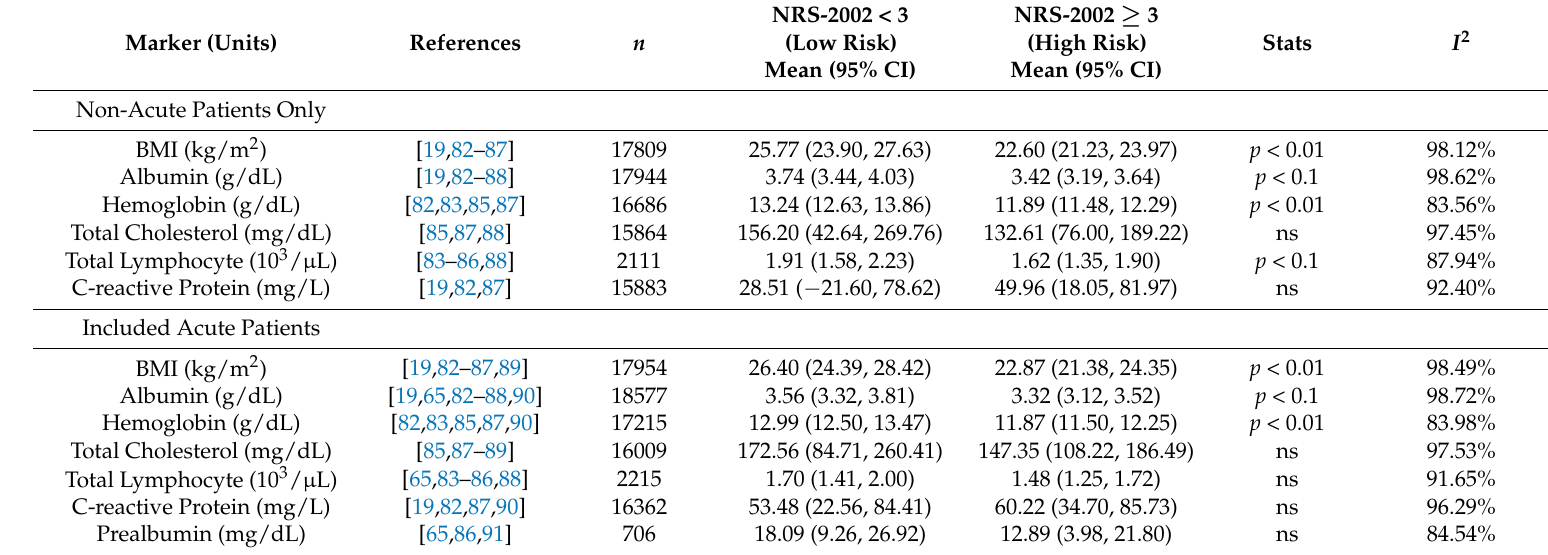
Table 4. Mean biomarker levels in 2 subgroups of malnutrition risk status defined by NRS-2002 1